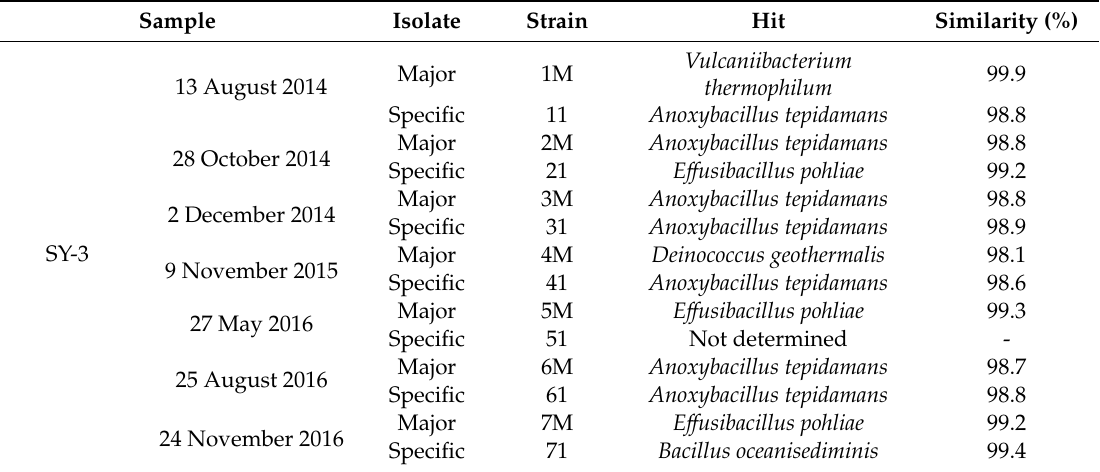
Table 2. Identification and isolation of major and specific thermophilic